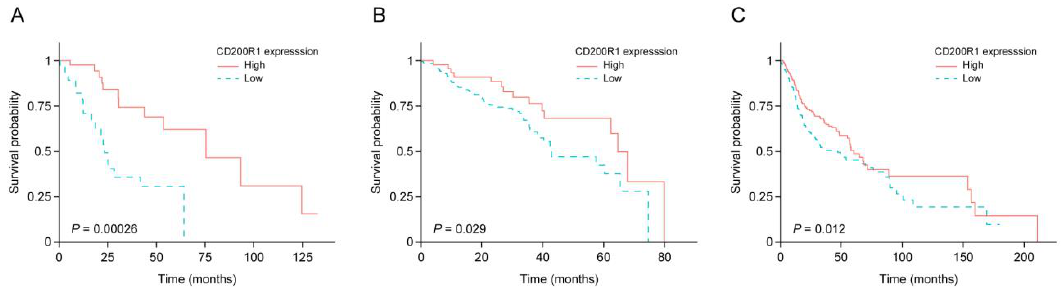
Figure 1. Kaplan–Meier survival curve for changes in OS according to CD200R1 mRNA expression in the Korean cohort ( A ), the GEO (GSE65858) ( B ), and TCGA HNSCC ( C ) data. Patients with high expression of CD200R1 (yellow solid line) showed longer OS compared with those with low expression (blue dotted line). The p -values were calculated using the log-rank test.